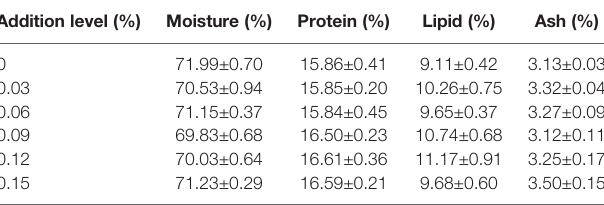
TABLE 5 | Effect of TB supplementation on whole body composition of juvenile blunt snout bream a .